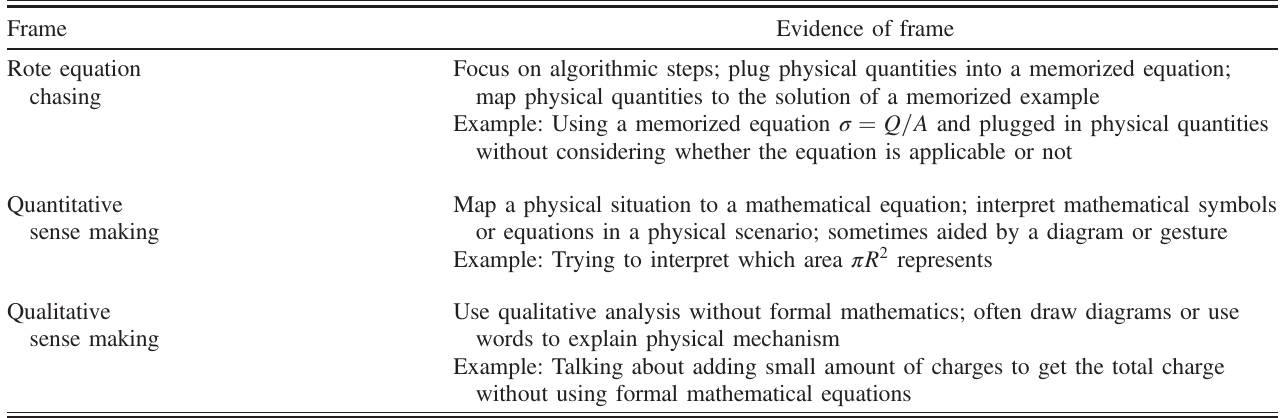
TABLE I: Three frames and their indicators. Frame Evidence of